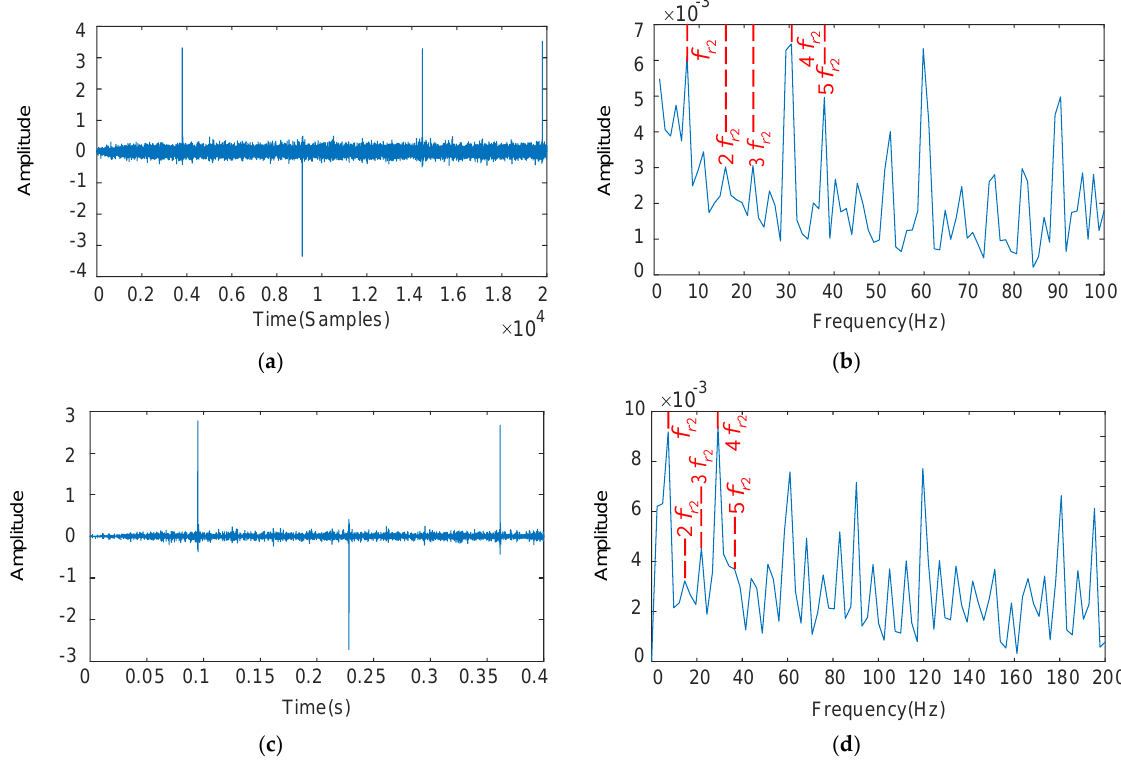
Figure 13. The IMS gear deconvolution results by MCKD: the filtered time domain waveform and their spectrum ( a , b ); the results obtained by MCKD + RSSD: the filtered time domain waveform and their spectrum ( c , d ). The bearing inner ring fault signals and bearing rollers fault signals are directly pro- cessed with the optimized parameters of the method proposed in this paper, so as to